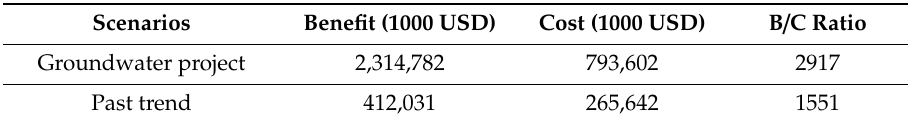
Table 8. Results and sensitivity test.